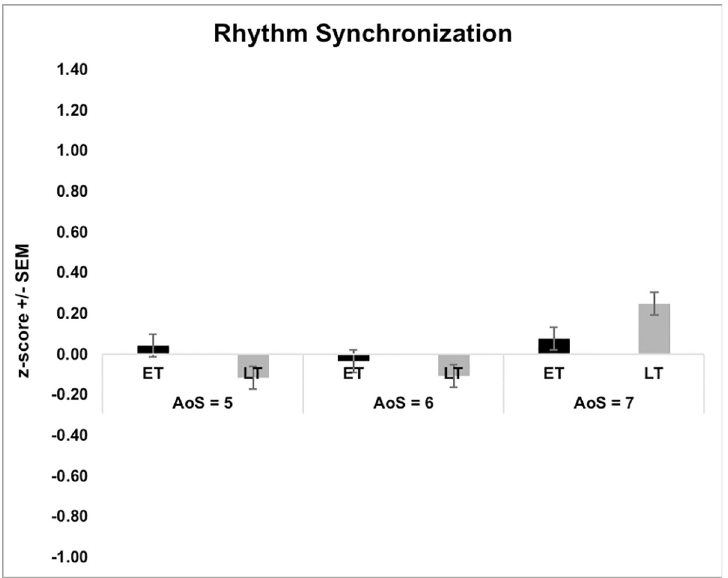
Fig 6. Results of one-way ANOVA for children’s Rhythm Synchronization Task (c-RST). Bars represent early- trained (ET) and late-trained (LT) musicians at three age of start cut-offs. Performance is measured as age-based z-